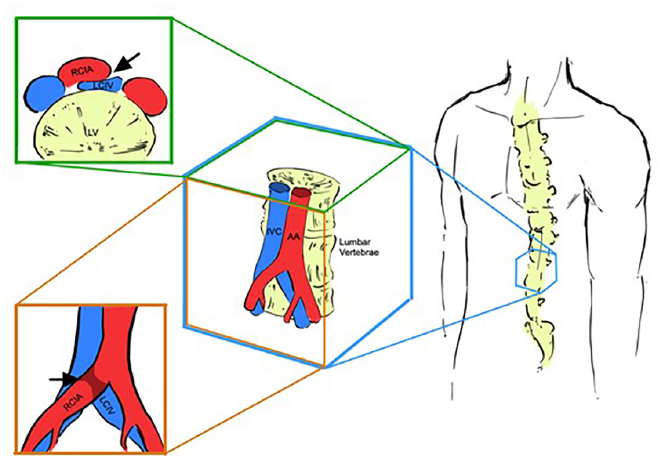
Figure. Area of compression (black arrows) in May-Thurner syndrome, as viewed in the coronal (top left) and sagittal planes (bottom left) (medical Illustration design by Dylan Ma). IVC, inferior vena cava; AA, abdominal aorta; RCIA, right common iliac artery; LCIV, left common iliac